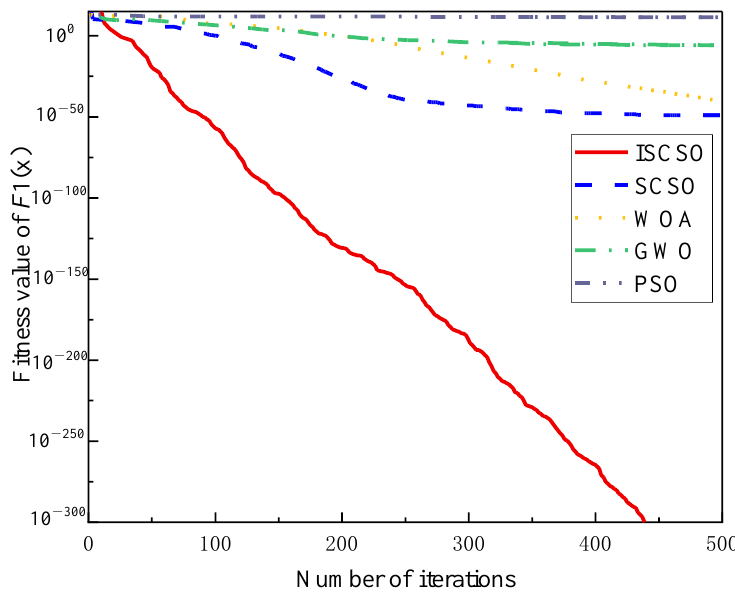
Figure 10. Comparison of the optimization search for F 1 ( x ) for each optimization algorithm.